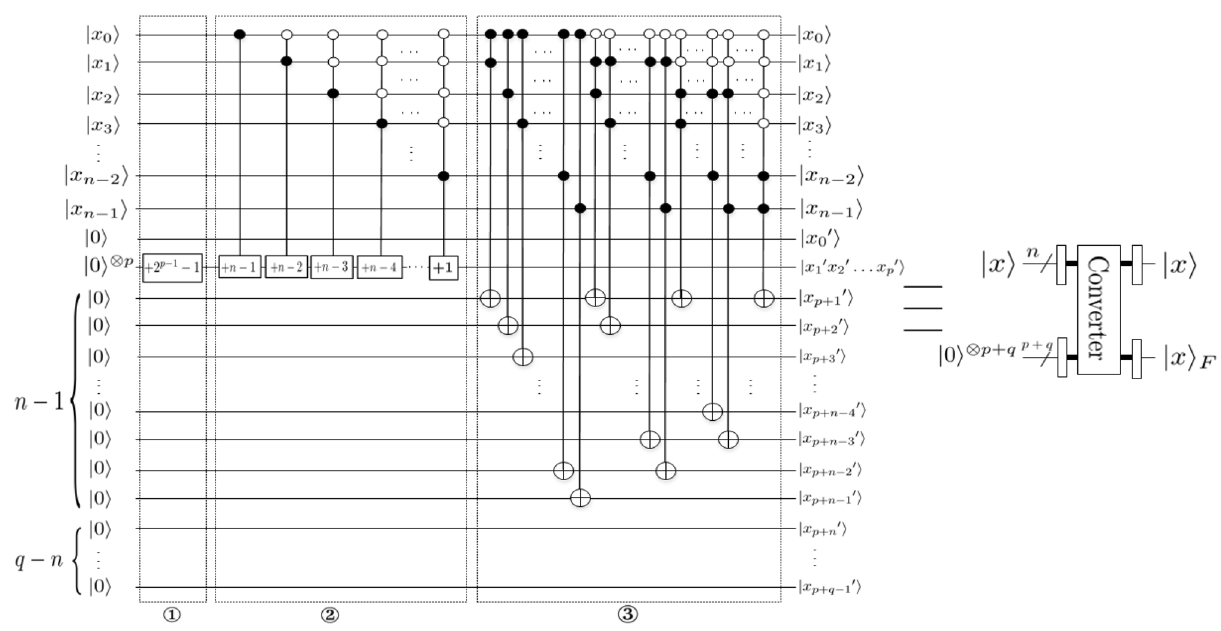
Figure 14. Converter